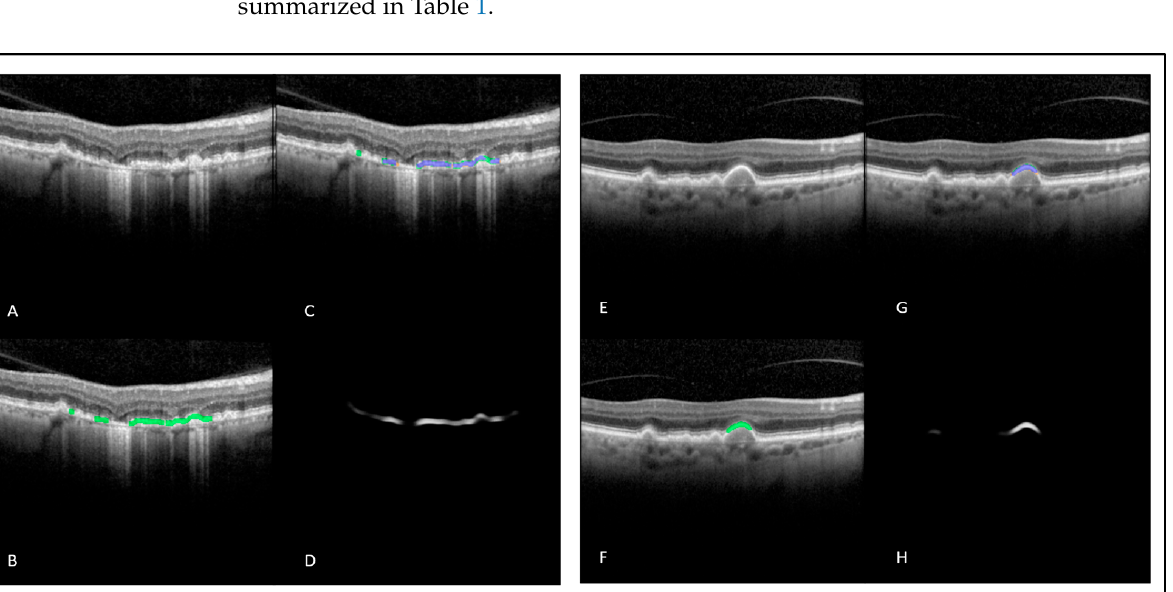
Table 1. Summary of DL-based results for detection and measurement of EZ At-Risk . DL: deep learning; EZ: ellipsoid zone.